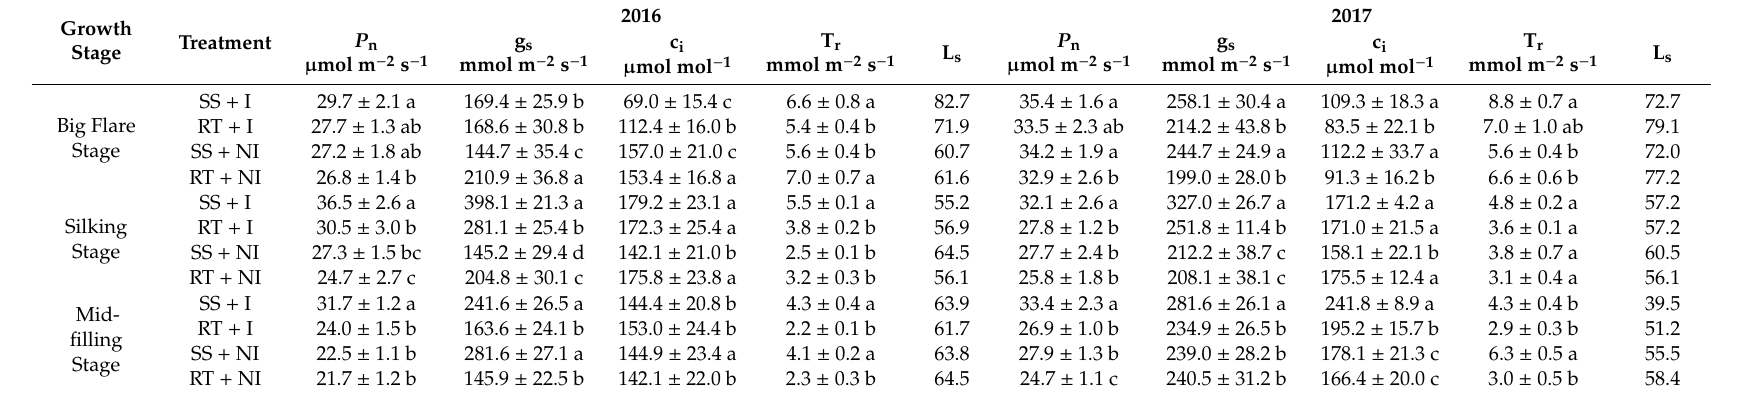
Table 4. E ff ects of di ff erent tillage practices on the photosynthetic capacity of summer maize at di ff erent growth